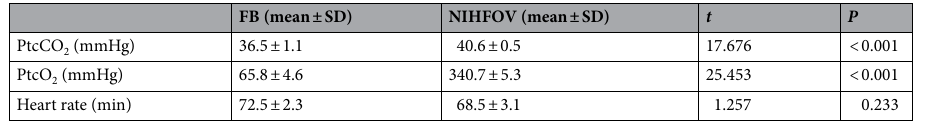
Table 2. Changes in medical physiological parameters with and without NIHFOV. FB Free breathing, NIHFOV Non-invasive high-frequency oscillatory ventilation, PtcCO 2 Transcutaneous partial pressure of the CO 2 , PtcO 2 Transcutaneous partial pressure of the O 2 .